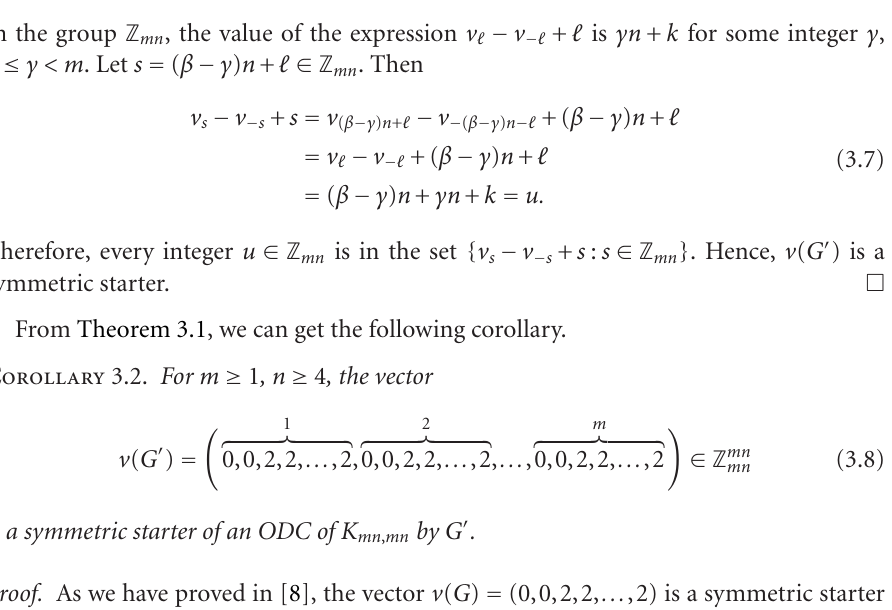
Figure 3.1. Symmetric starter of an ODC of K 15,15 by G (cid:6) = ( K 2,9 − E ( K 1,3 )) ∪ E 19